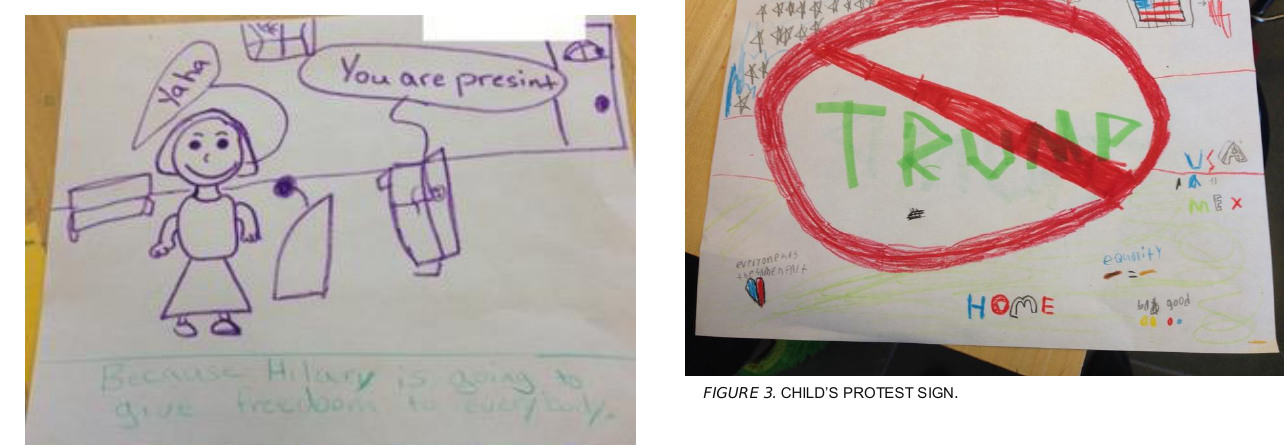
FIGURE 1. CHILD’ S DEPICTION OF A CAMPAIGN SPEECH BY THEN- CANDIDATE DONALD TRUMP.